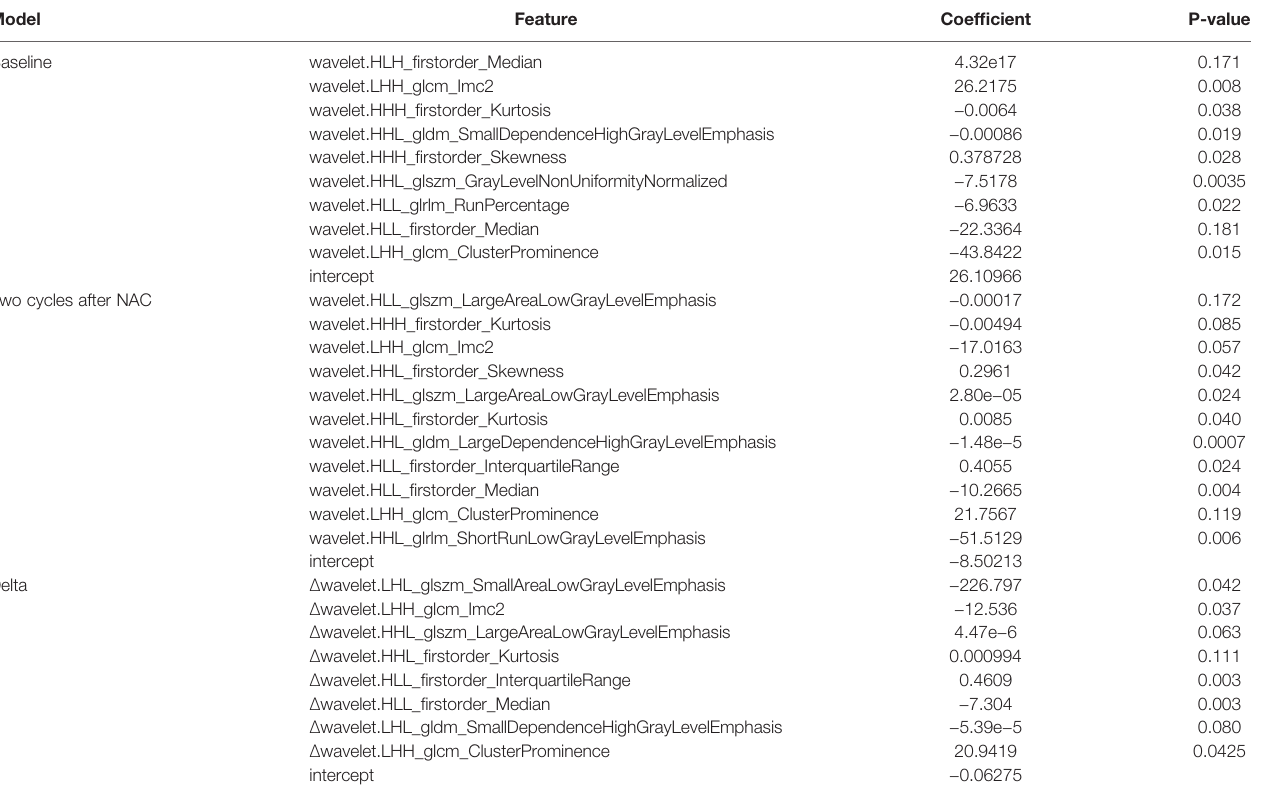
TABLE 2 | Selected features and their coef fi cients in the